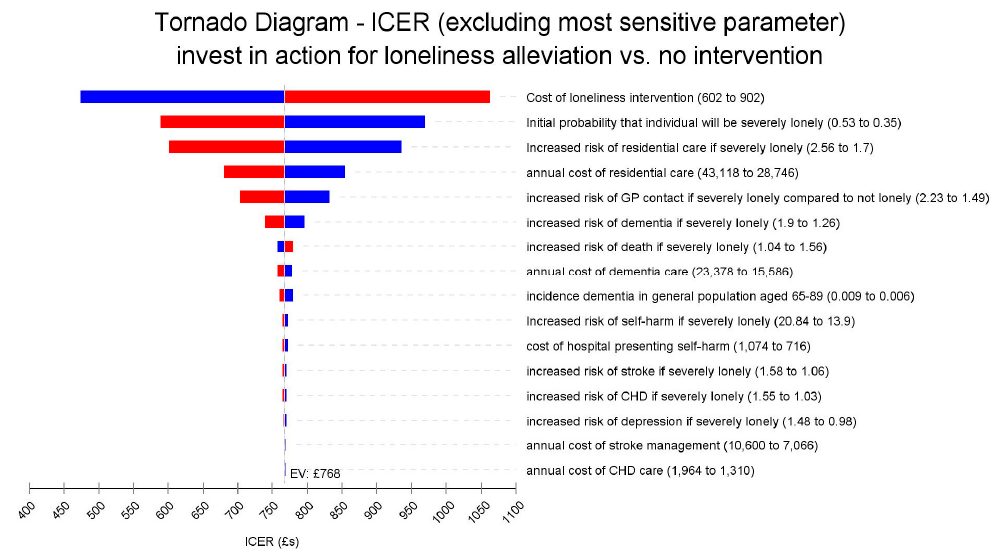
Figure 3. Tornado diagram of the univariate sensitivity analyses excluding the effectiveness parameter.